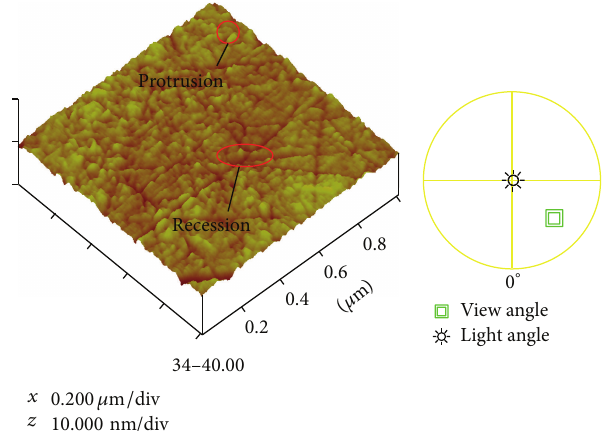
Figure 2: 3D AFM images detected of the protrusion (6.966 nm) and recession (4.458 nm) of black spots, obtained with PSIA AFM from PARK Company, Korea, using tapping mode and a scan size of 2 𝜇 m.